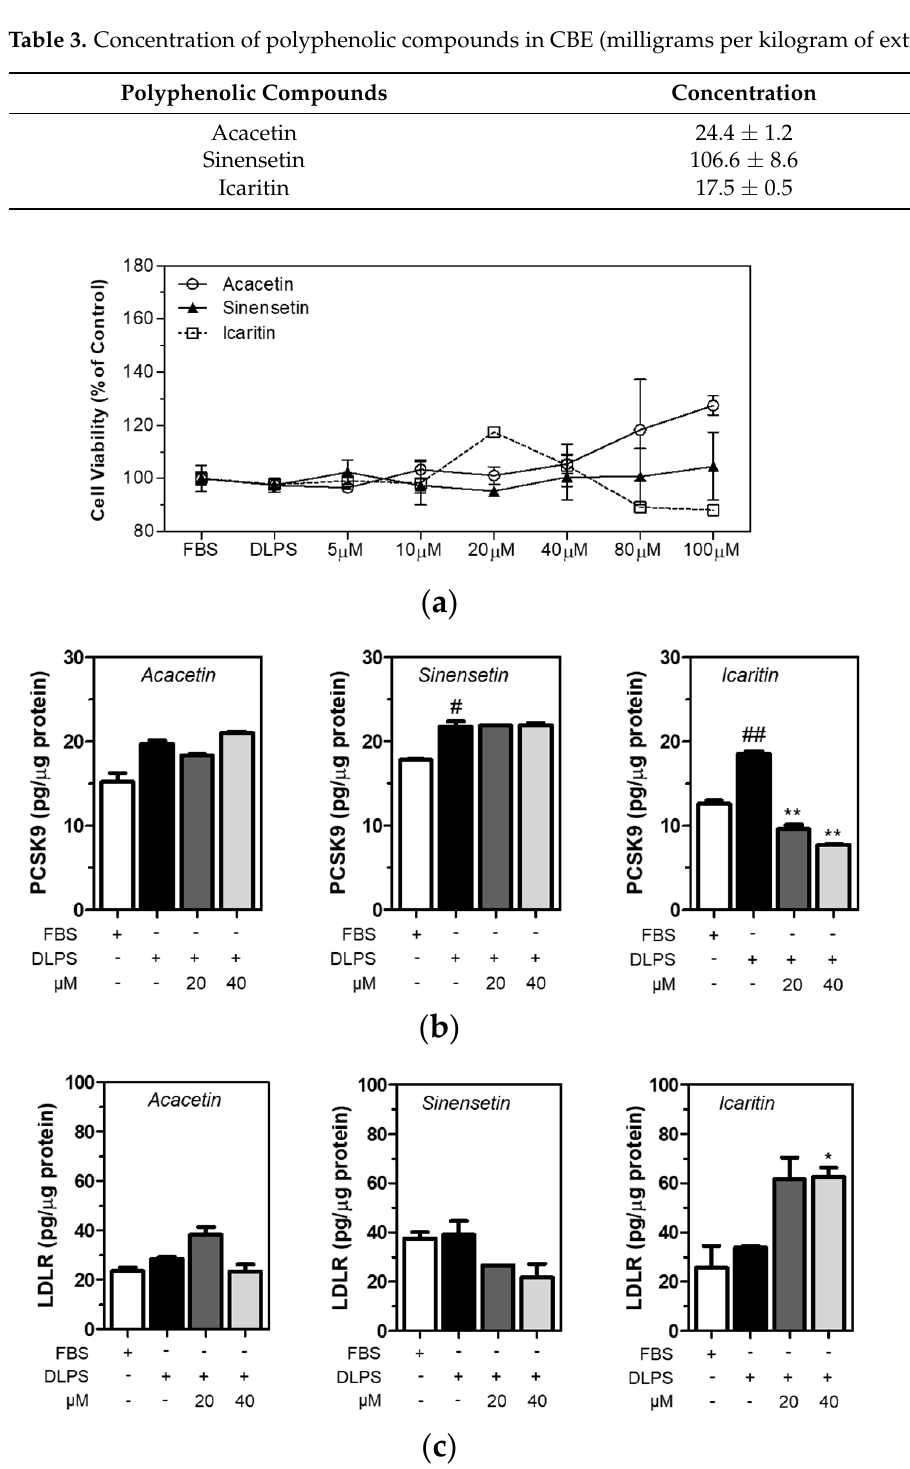
Figure 3. HepG2 cells were treated with FBS or DLPS in the presence or absence of acacetin, sinensetin, and icaritin (0, 5, 10, 20, 40, 80 µ M), and MTT assay was performed to measure cell viability ( a ). The PCSK9 level in HepG2 cells treated with acacetin, sinensetin, and icaritin of up to 40 µ M concentration was measured using ELISA ( b ). The LDLR level in HepG2 cells treated with acacetin, sinensetin, and icaritin of up to 40 µ M concentration was measured using ELISA ( c ). #; significant difference between cells treated with FBS and DLPS (Student’s t -test, # p < 0.05; ## p < 0.01). *; significant difference between cells treated with DLPS and compounds (Student’s t -test, * p < 0.05; ** p < 0.01). Table 3. Concentration of polyphenolic compounds in CBE (milligrams per kilogram of extract). Polyphenolic Compounds